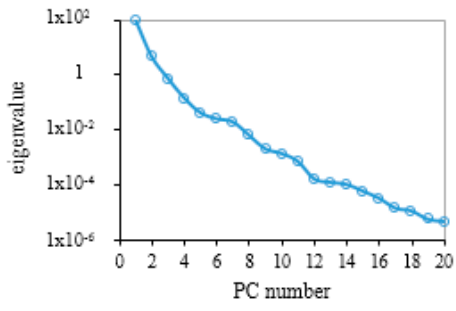
Figure 2. The twenty leading eigenvalues of the principal components (PCs) calculated from the reflectance spectra of the simulated training dataset for the range 400–2500 nm.